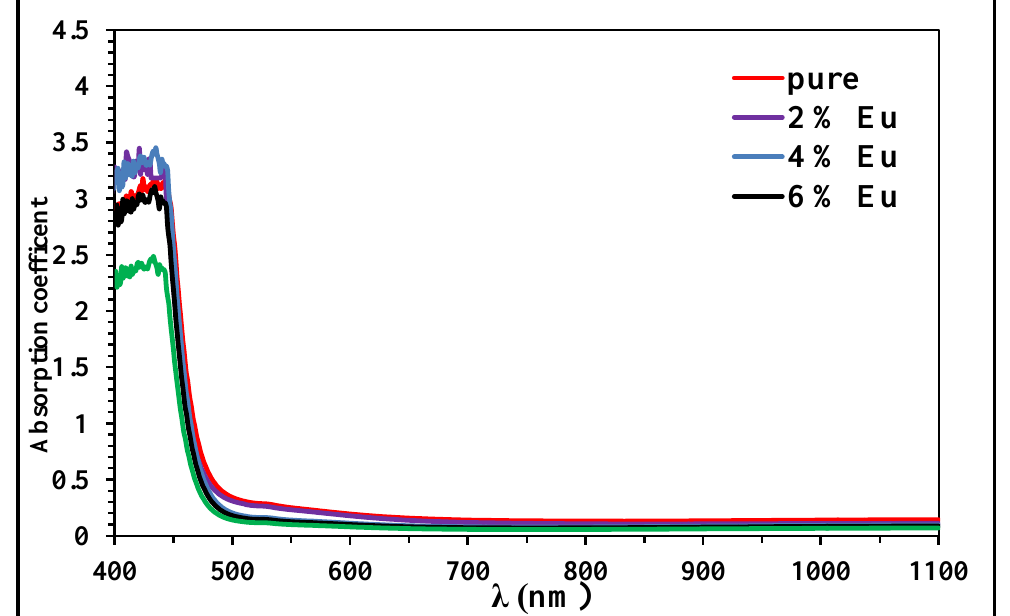
Fig.4: Absorption coefficient as a function of wavelength for V and 8) wt %. Eu